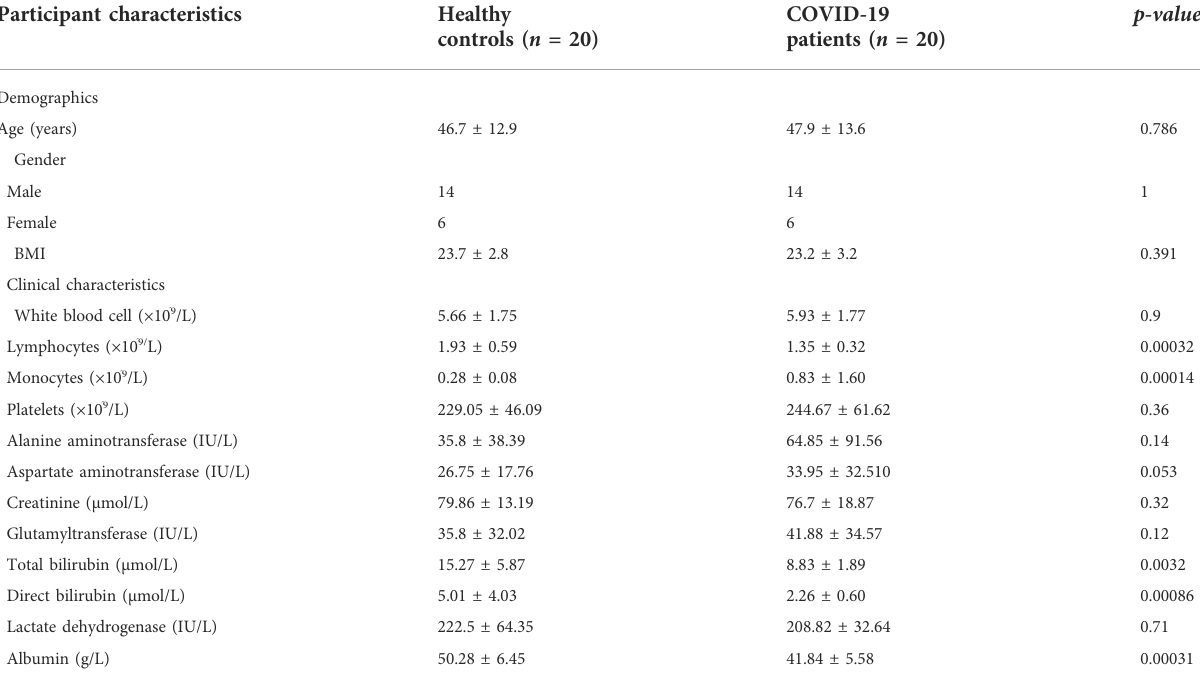
TABLE 1 Baseline characteristics of COVID-19 patients and healthy